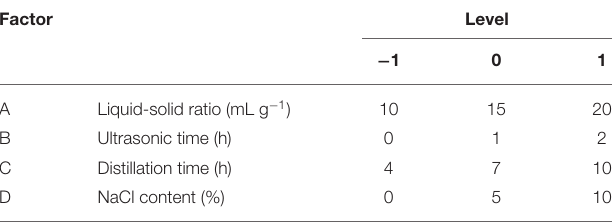
TABLE 1 | Factors and levels of RSM